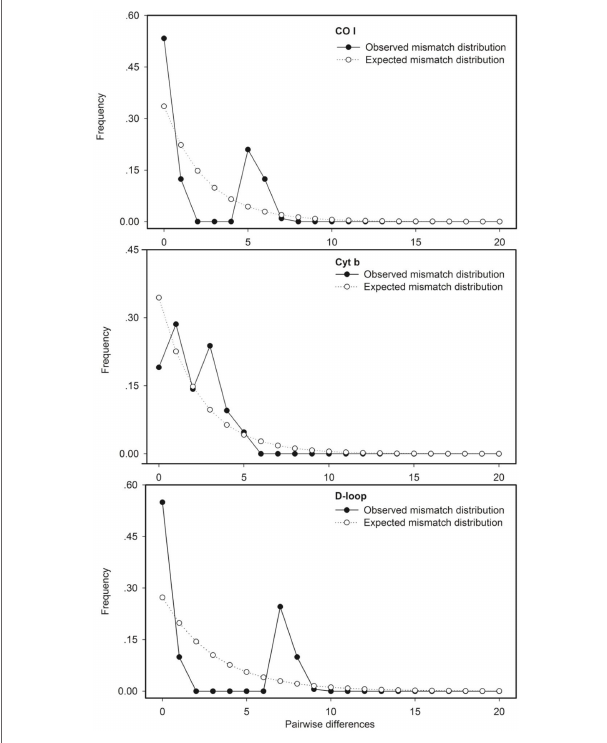
FIGURE 3 | Mismatch distribution of partial sequences of the mtDNA CO I, Cyt b, and D-loop markers for the wild population of Procypris